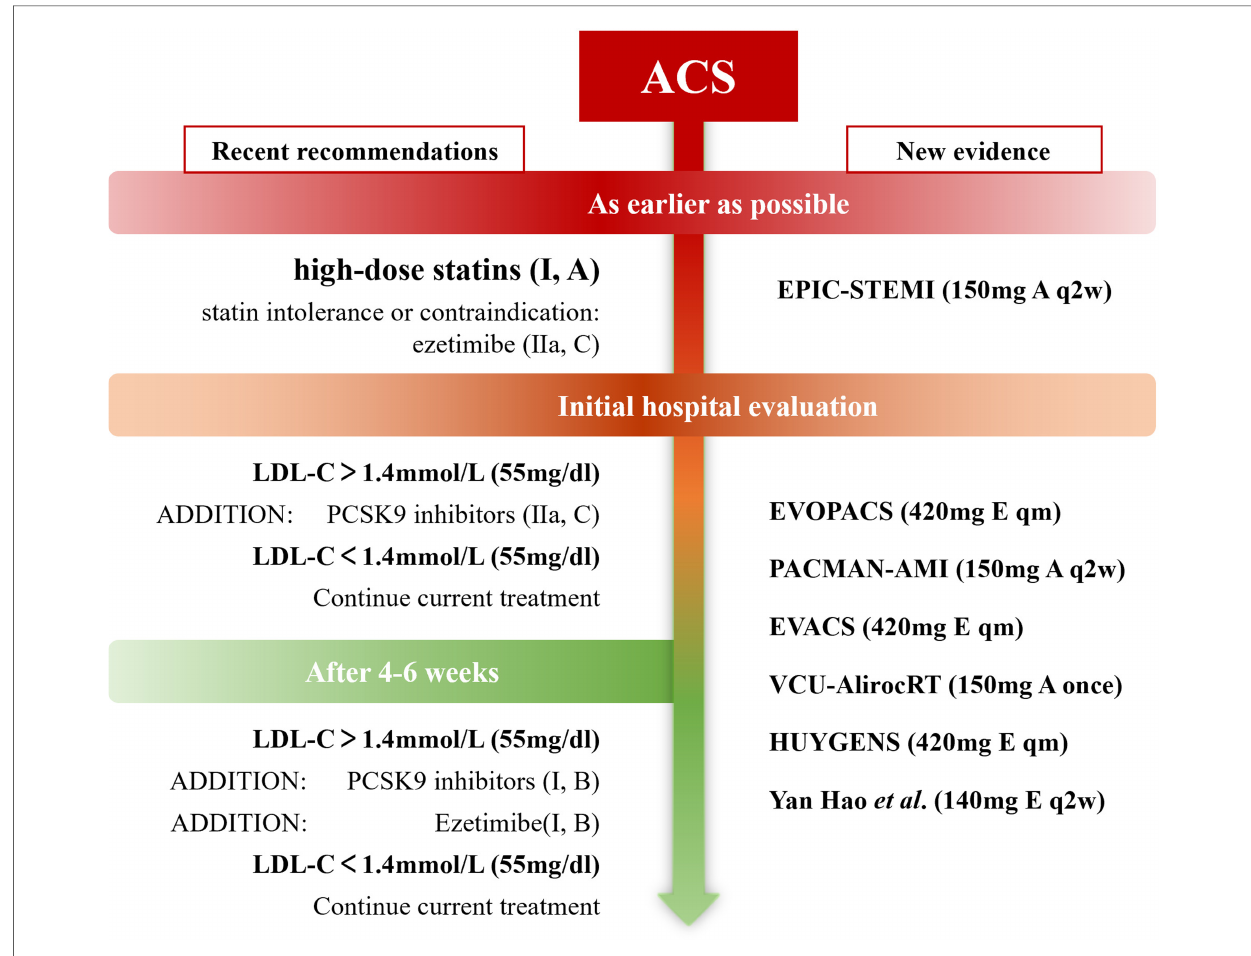
FIGURE 2 Recent recommendations and new evidence on the timing of PCSK9 inhibitor initiation (New evidence: A: alirocumab; E: